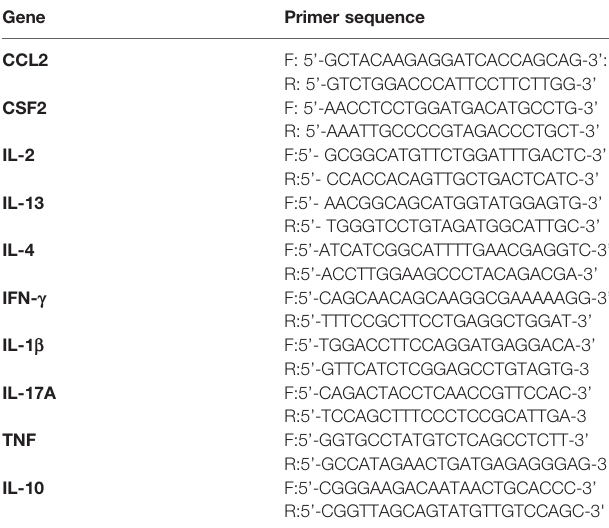
TABLE 1 | Gene speci fi c